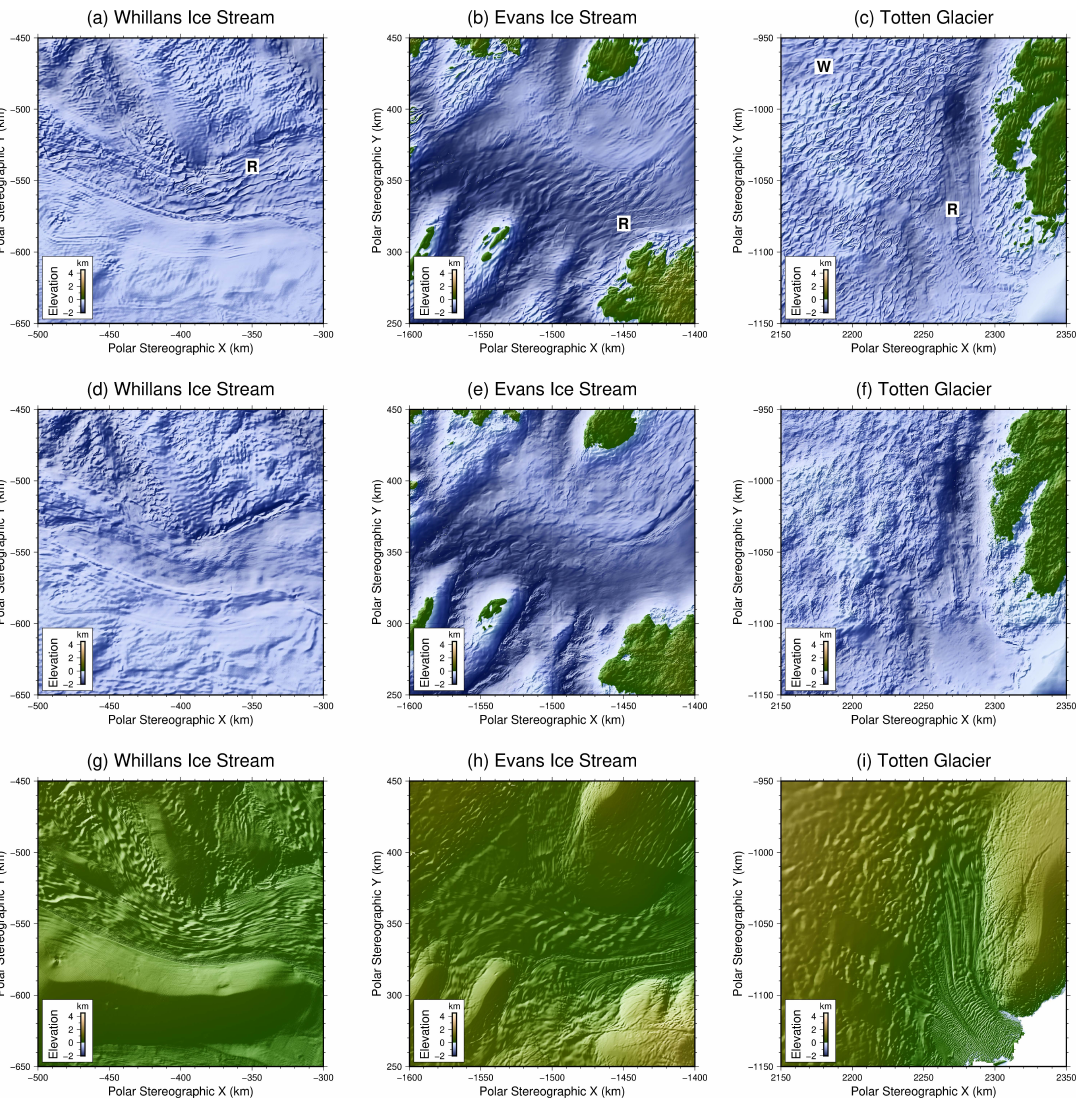
Figure 8. Close-up view of different DEM around Antarctica. ( a – c ) show DeepBedMap_DEM [17]; ( d – f ) show MB_DeepBedMap_DEM; ( g – i ) show the ice surface elevation model. Features of interest are annotated in black text against a white background: ridges R, wave patterns